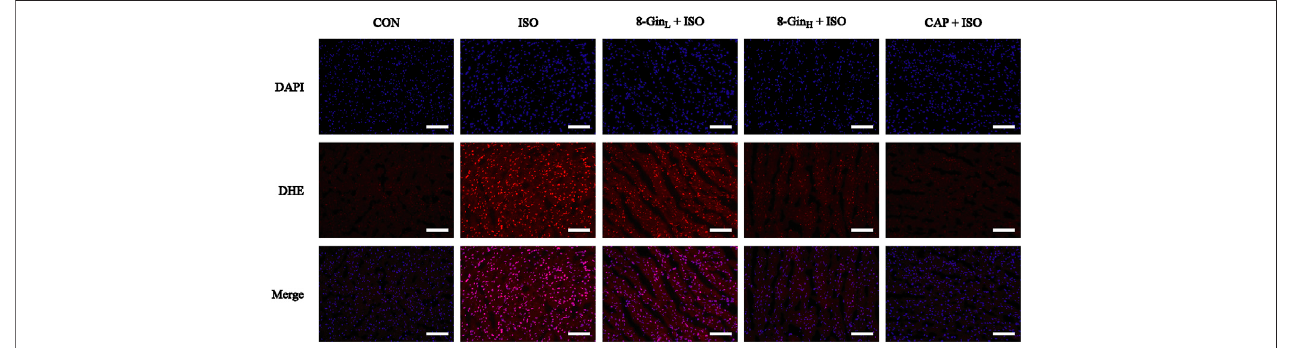
FIGURE 5 | Effects of 8-Gin on ROS generation in mice heart tissue. Generation of ROS was measured by a dihydroethidium (DHE) probe staining of mice heart in CON, ISO, 8-Gin